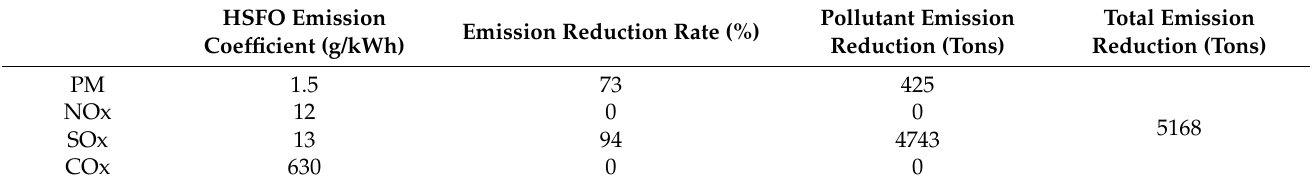
Table 9. Emission reduction in the first year after scrubber installation.